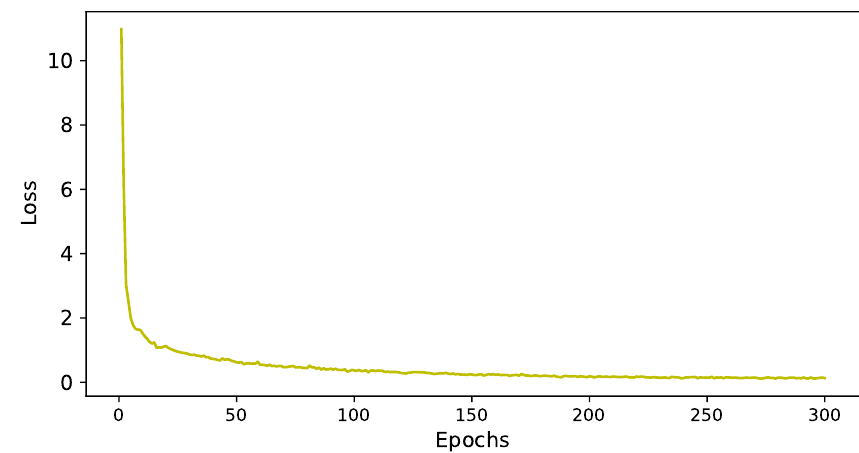
Figure 6. Loss curve on the DermaMNIST